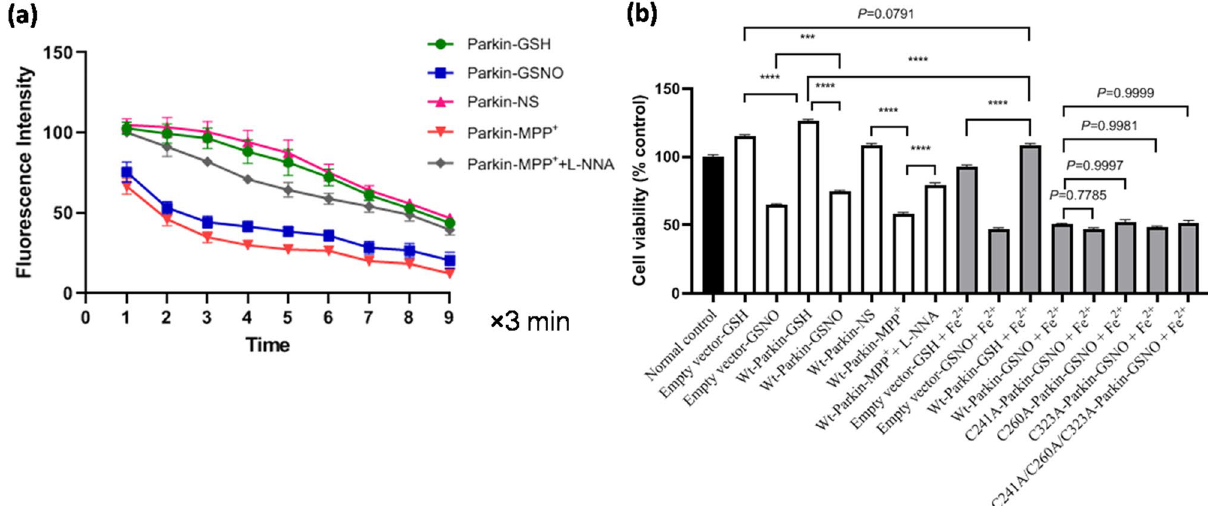
Figure 5. The S-nitrosylation of parkin enhanced ferrous iron influx and reduced cell viability in parkin- transfected SH-SY5Y cells. ( a ) Statistical analysis for changes in ferrous iron uptake, following different treatment (200 μM of MPP + ; 200 μM of GSNO; 200 μM of MPP + + 1 mM of L-NNA) for 24 h in parkin- transfected SH-SY5Y cells. P = 0.001, parkin-GSNO versus parkin-GSH; P = 0.0008, parkin-MPP + versus parkin-NS; P = 0.0023, parkin-MPP + + L-NNA versus parkin-MPP + . N = 6. ( b ) Statistical analysis for cells viability following different treatment for 24 h in parkin-transfected SH-SY5Y cells. **** P = 0.0000, *** P = 0.0004. N =